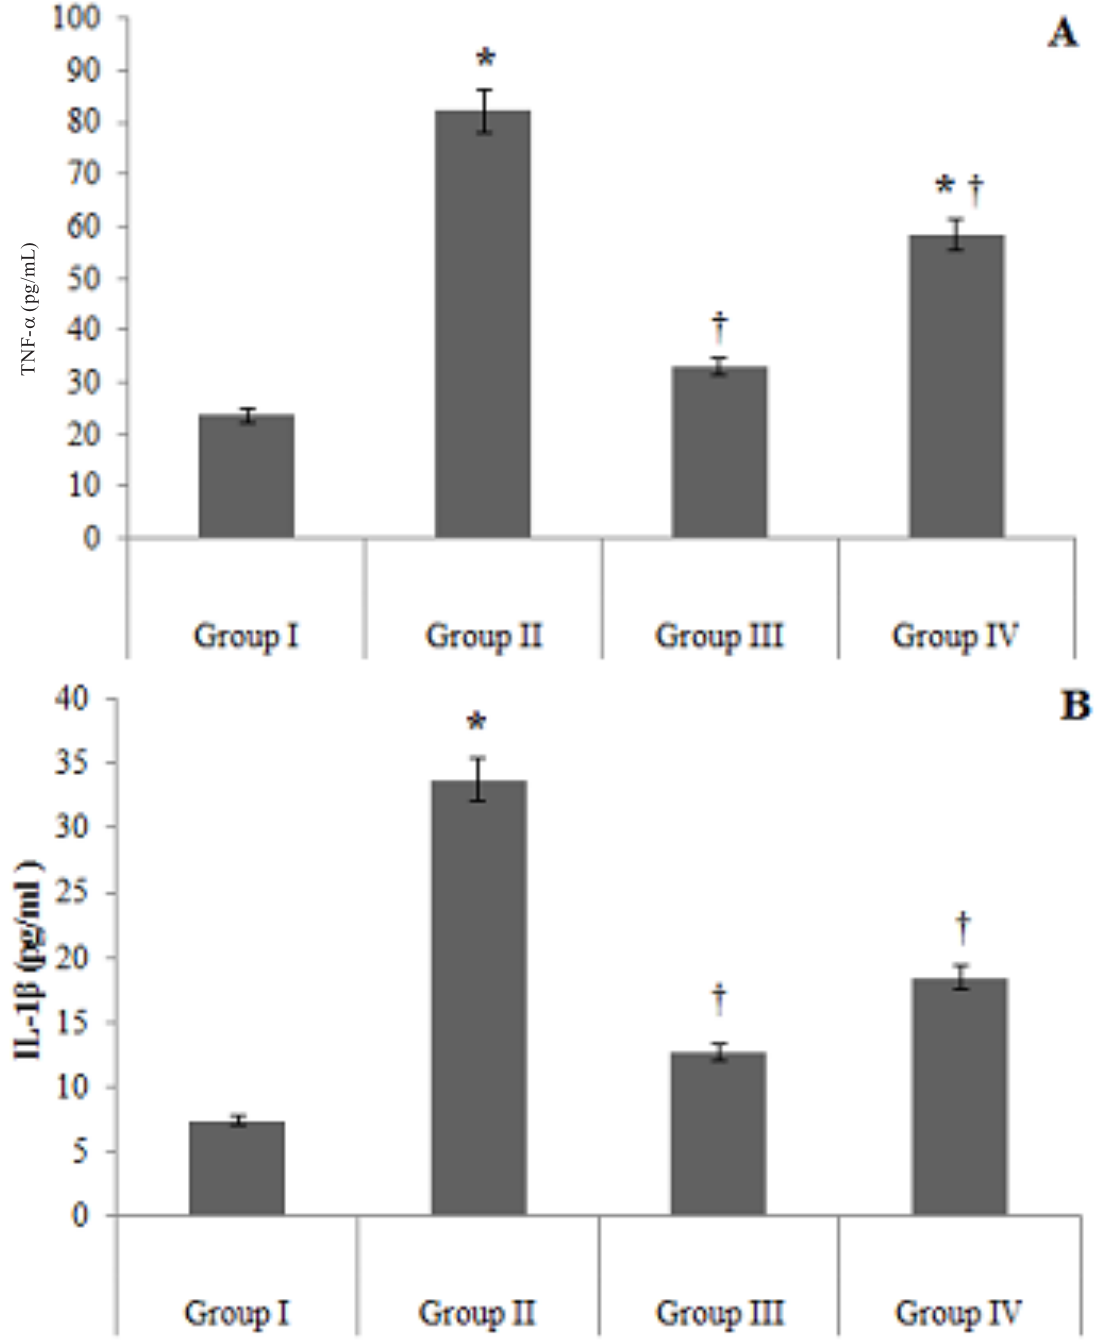
FIGURE 3 - Effects of sitagliptin on APAP-induced alterations of (A) tumor necrosis factor- α (pg/mL) and (B) interleukin-1 β (pg/mL). Group I: normal control group; group II: APAP-treated group; group III: sitagliptin-treated group (10 mg/kg/day) 5 days before APAP administration; group IV: N -acetylcysteine-treated group (100 mg/kg orally). Data are expressed as mean ± SEM for n = 10. * : P < 0.05 compared to normal control group; †: P < 0.05 compared to APAP control group by one-way ANOVA test followed by post hoc